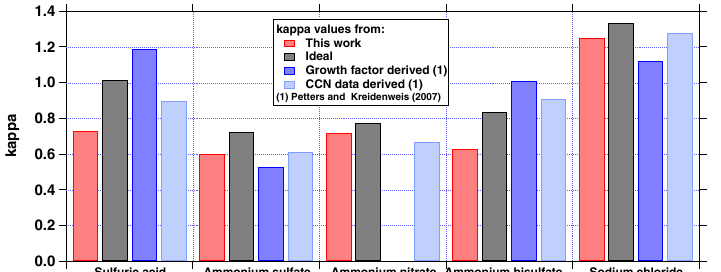
Figure 2. Comparison of average hygroscopicity parameters ( κ mean ) provided in Table 1 in Petters and Kreidenweis (2007) with the κ values derived in this work based on a water activity of 0.9975 at the point of CCN activation as input to the E-AIM model II and IV (http:// www.aim.env.uea.ac.uk/aim/model2/model2a.php). The water activity was derived from the following assumptions: κ = 0.3, supersaturation SS = 0.5%, temperature T = 5 ◦ C, and surface tension σ = 74.95mNm − 1 . The ideal κ values refer to a water activity of 1. Note that the growth-factor-derived values in Petters and Kreidenweis (2007) are based on a water activity of about 0.9. For NaCl the value reported in Petters and Kreidenweis (2007) is too low and should be around 1.5 instead (Zieger et al.,